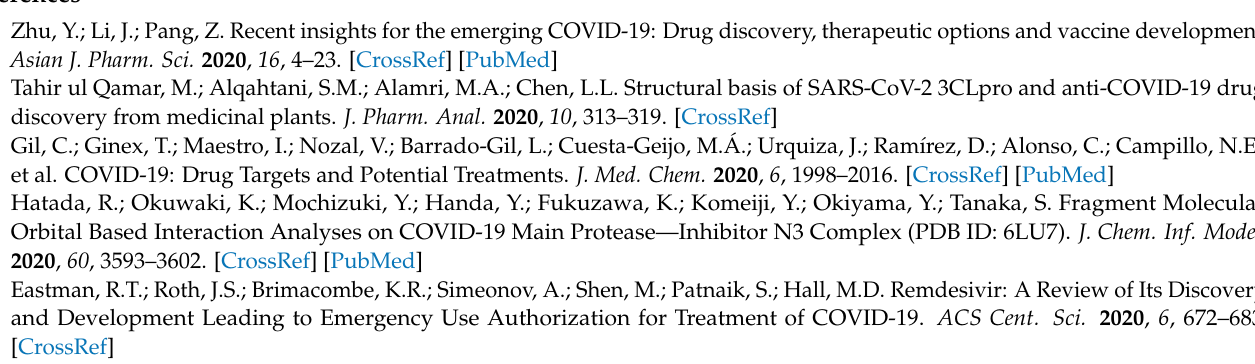
Table S7. Gris box used for the docking